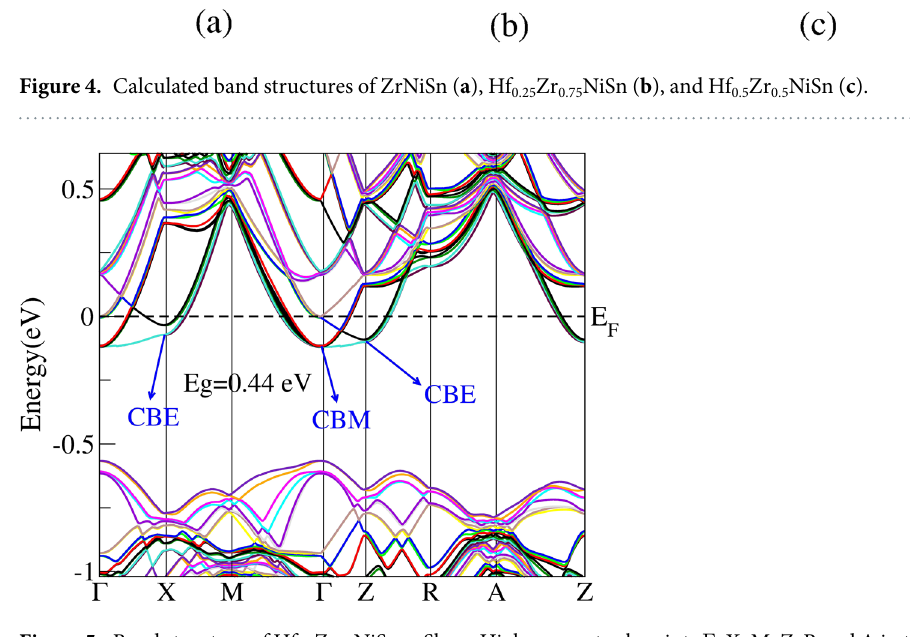
Figure 5. Band structure of Hf 0.5 Zr 0.5 NiSn 0.98 Sb 0.02 . High symmetry k points Γ , X, M, Z, R and A in the figure represent the points (0, 0, 0), (0, 0.5, 0), (0.5, 0.5, 0), (0, 0, 0.5), (0, 0.5, 0.5) and (0.5, 0.5, 0.5),